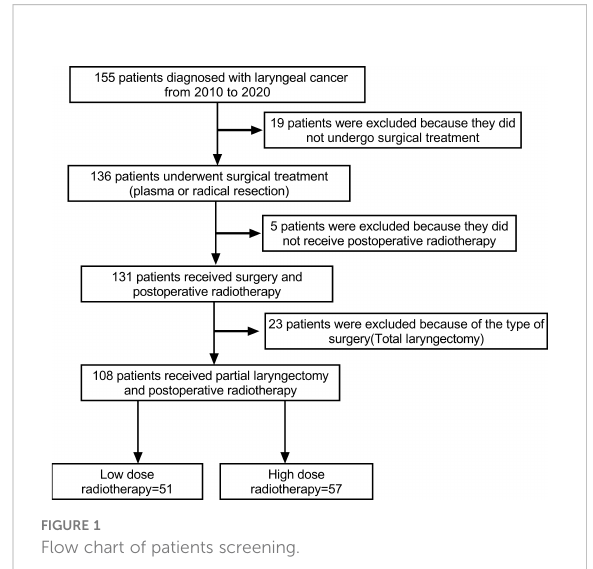
FIGURE 1 Flow chart of patients screening.